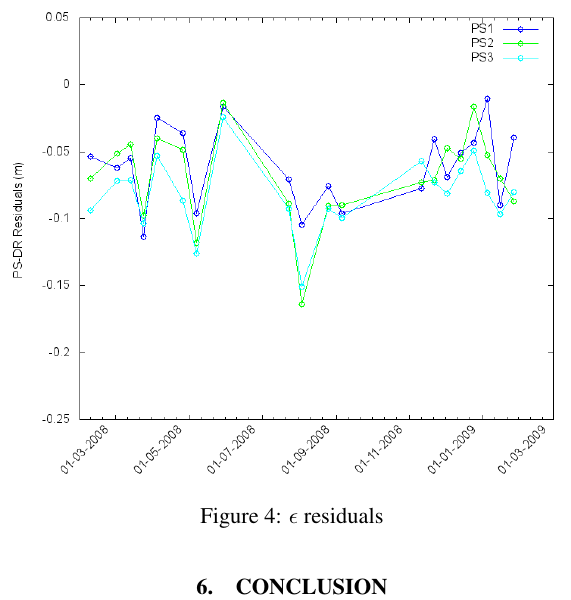
Figure 4: (cid:15)